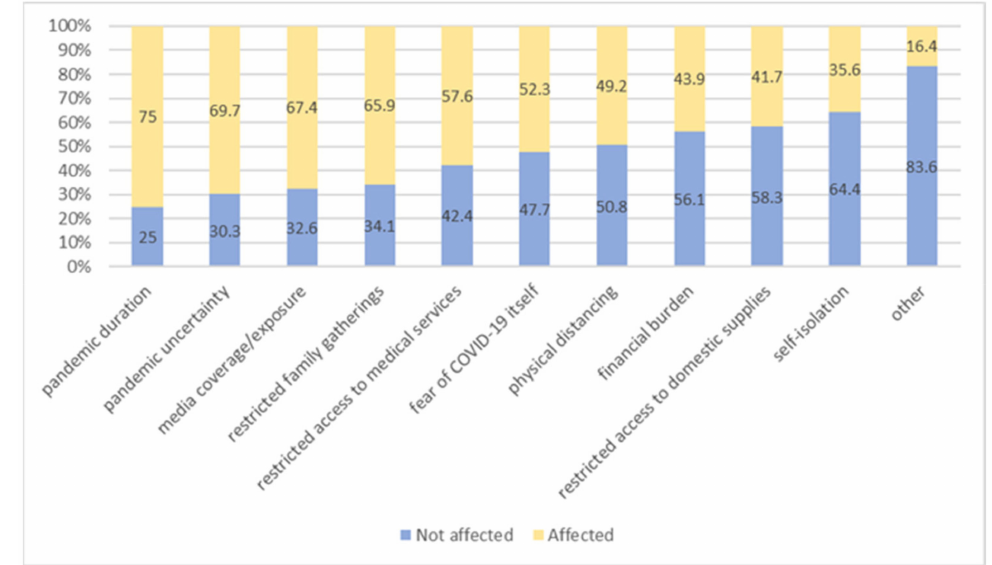
Figure 1. The proportion of the participants affected by COVID-19-related non-PTE